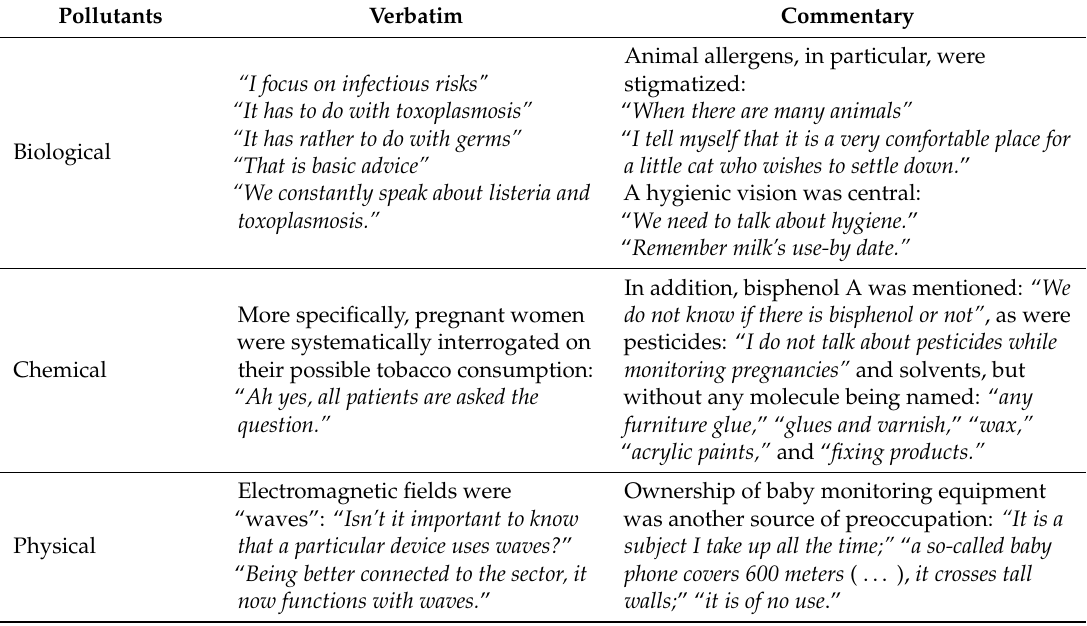
Table 3. Representations of perinatal professionals about environmental risks viewed by pollutants.